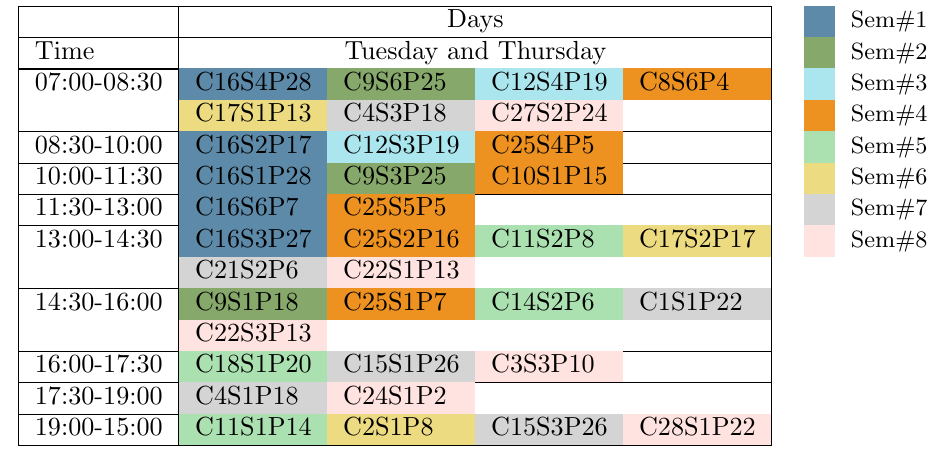
Figure 9. Timetableof fourth strategy for courses in day scheme B: Tuesday and Thursday, two classes of 1 h and a half per